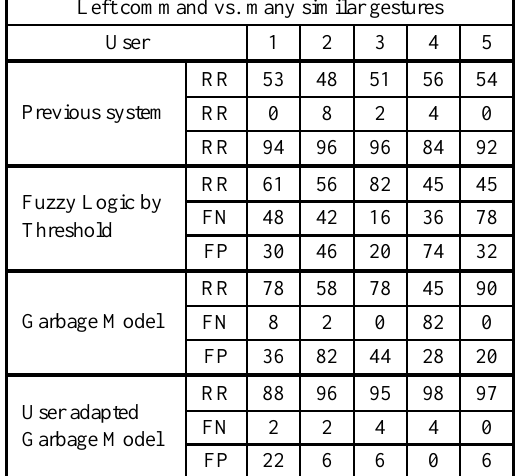
Table 7. (continued) Experimental results for ‘left’ command Left command vs. many similar